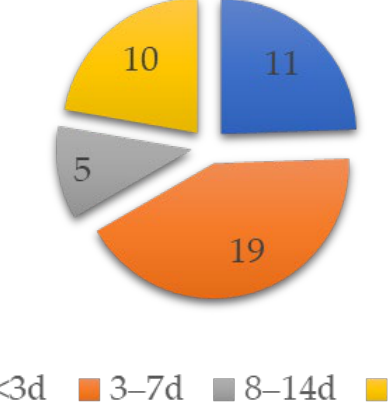
Figure 4. Patient numbers by onset days of symptoms.